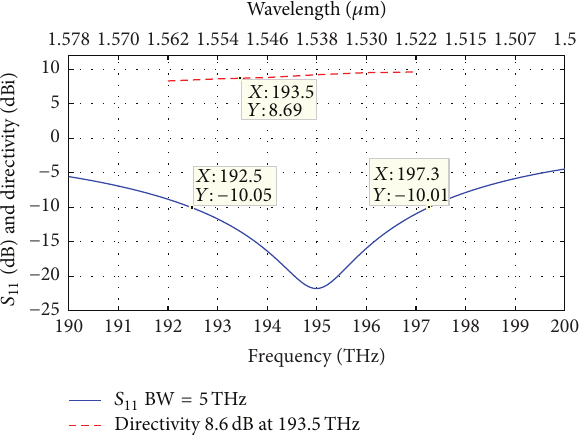
Figure 8: Return loss 𝑆 11 and directivity of